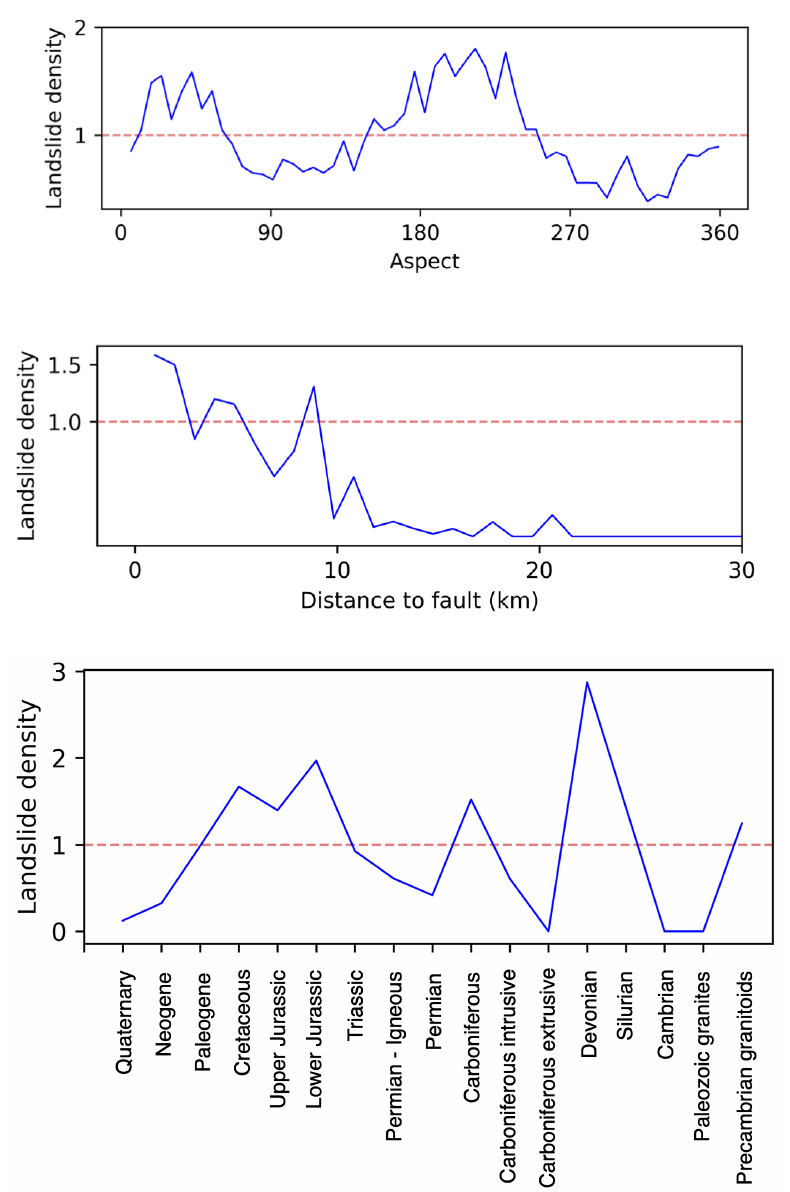
Figure A7. Landslide